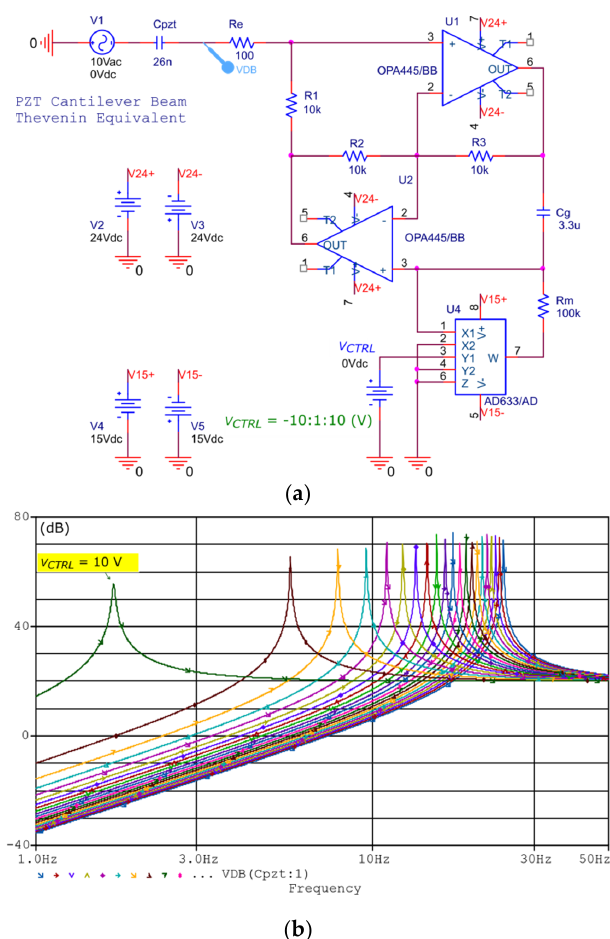
Figure 3. Voltage-controlled synthetic inductor: ( a ) based on AD633 analog multiplier, and ( b ) the resonant frequency simulation results for voltage control ( V CTRL ) from −10 V to 10 V with 1 V step.